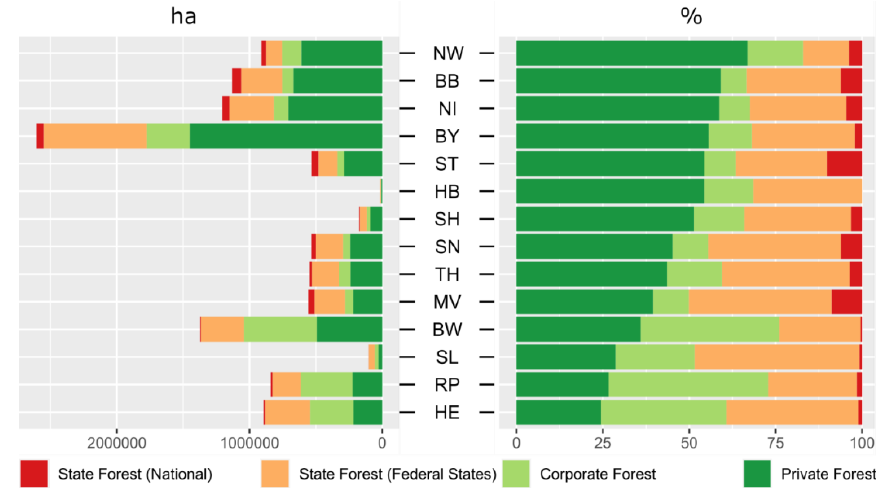
Figure 6. Forest ownership in Germany per federal state in terms of area in hectares and in percentages of the forested area [22].